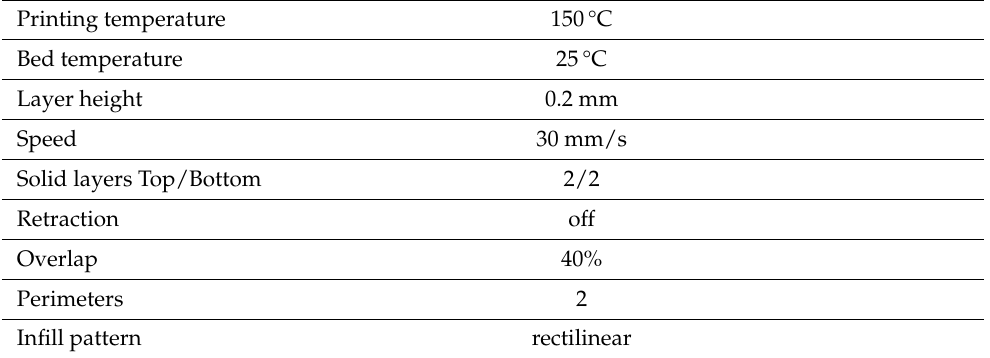
Table 2. Printing parameters for alumina material on FFF technology.